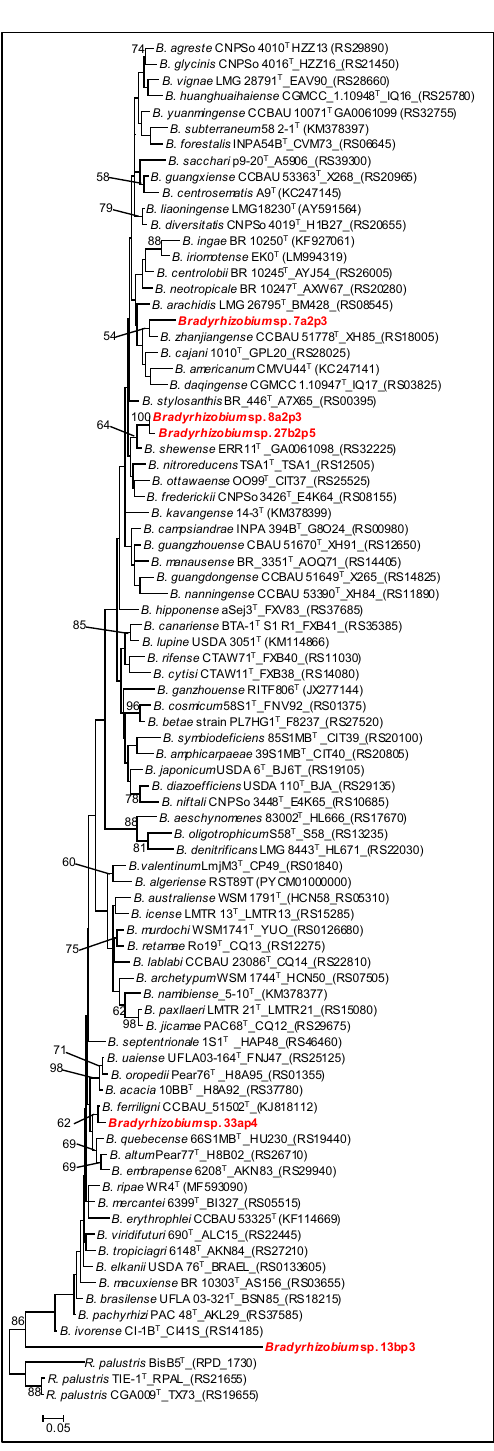
Figure 7. A recA maximum-likelihood phylogeny of Bradyrhizobium strains associated with pigeonpea. The strains in red originated from pigeonpea nodules. Bootstrap support for the groupings above 50% are indicated. Information regarding the type strain is provided while the GenBank accession number or locus tag for each species is indicated in brackets. Species names which appear in inverted commas (‘…’) are combinations which have not yet been validly published. The scale bar corresponds to the number of nucleotide changes per site. The model used is GTR+ I+ G with invariable proportion site value 0.4986 and gamma value 0.6930.